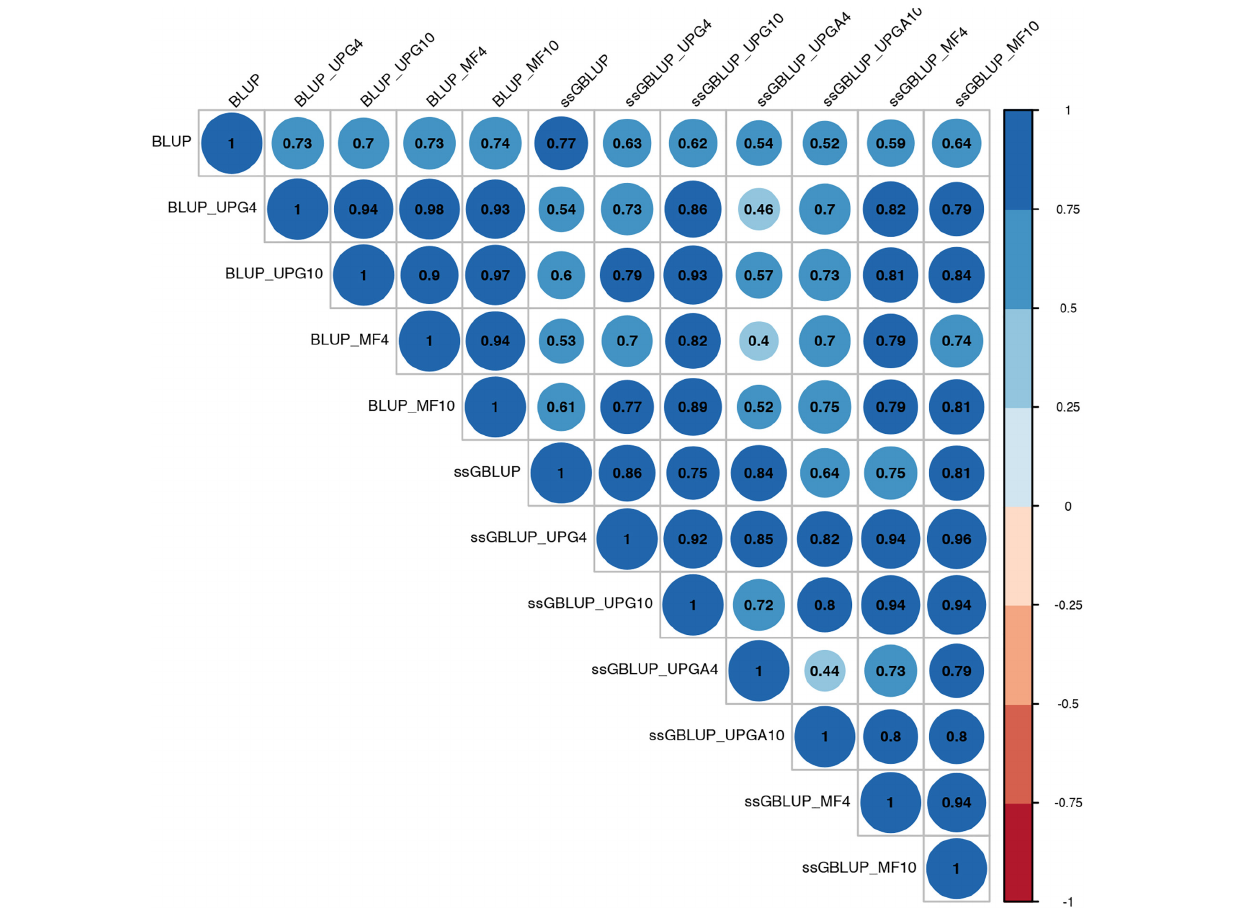
FIGURE 4 | Correlations between breeding values for weaning weight maternal estimated using various models with and without genetic